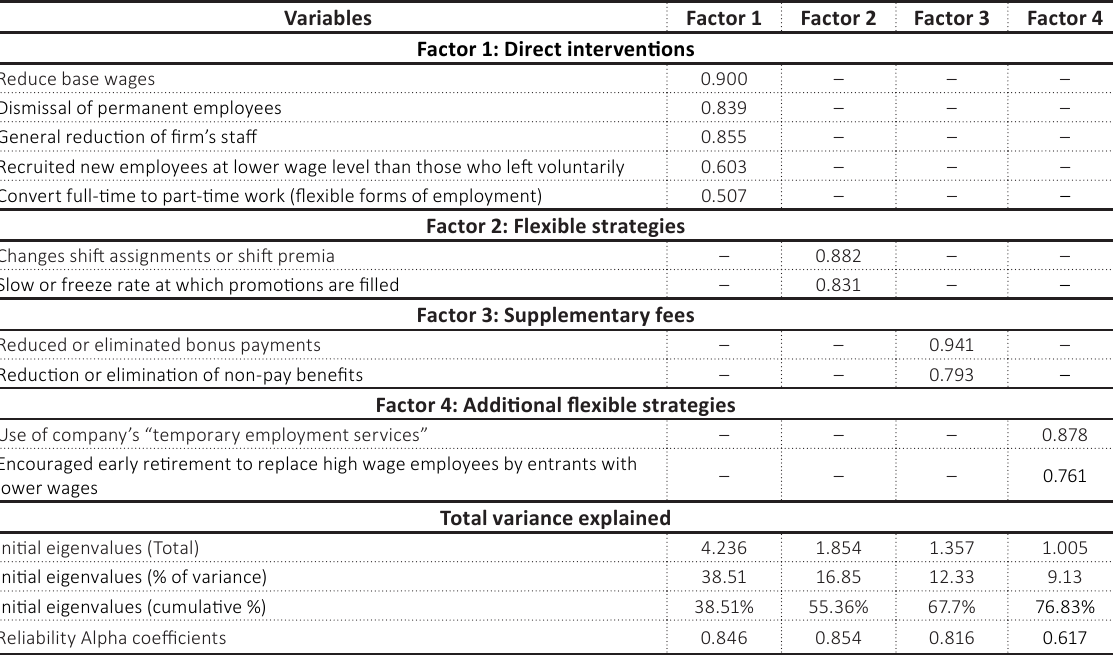
Table 9. Factor analysis of the strategies to reduce labor costs